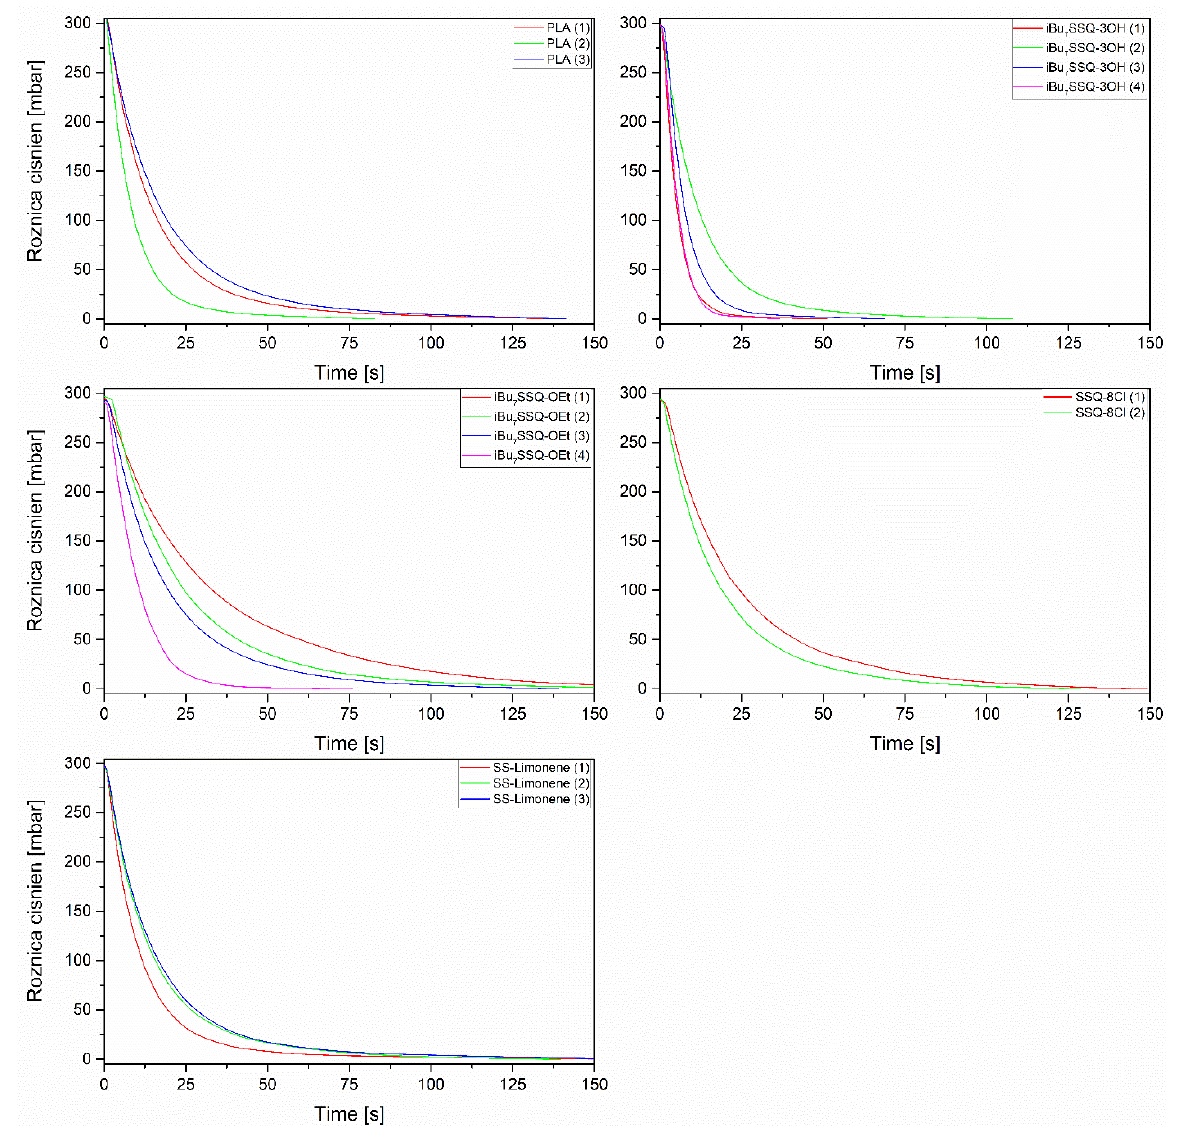
Figure 8. Flow resistance curves of the electrospun membranes prepared in this